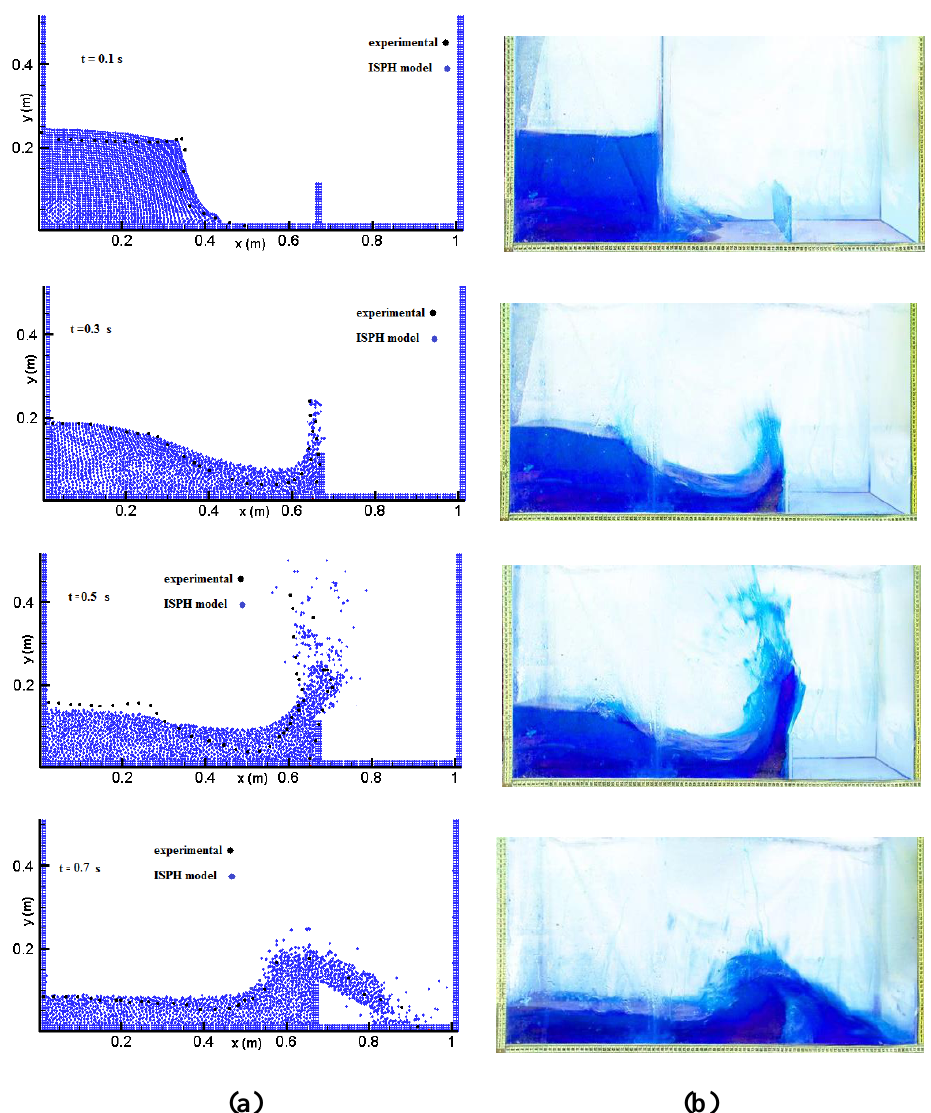
Figure 3 Comparison of (a) numerical results and (b) experimental observations; the observed digitized free- surface position is denoted by the black circle in